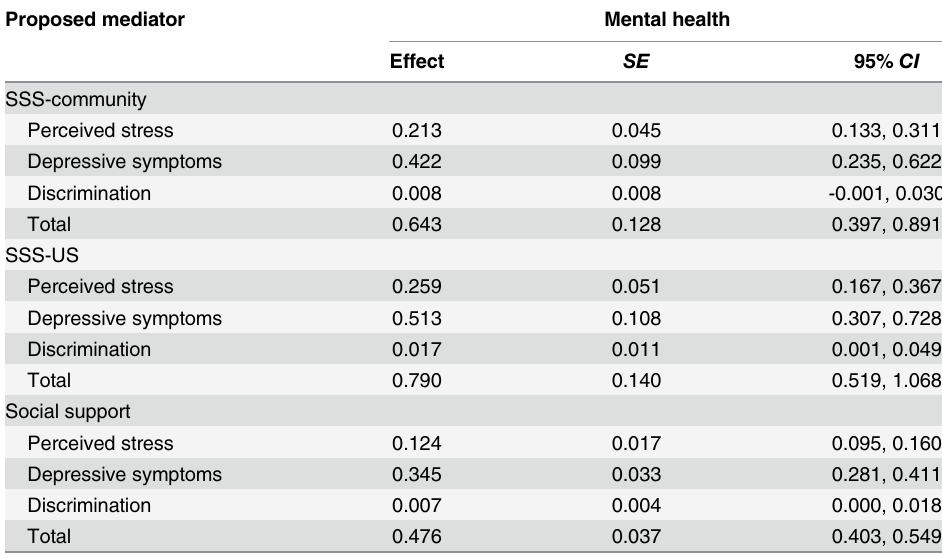
Table 2. Indirect Effects on Mental Health Outcomes in Multiple-Mediator